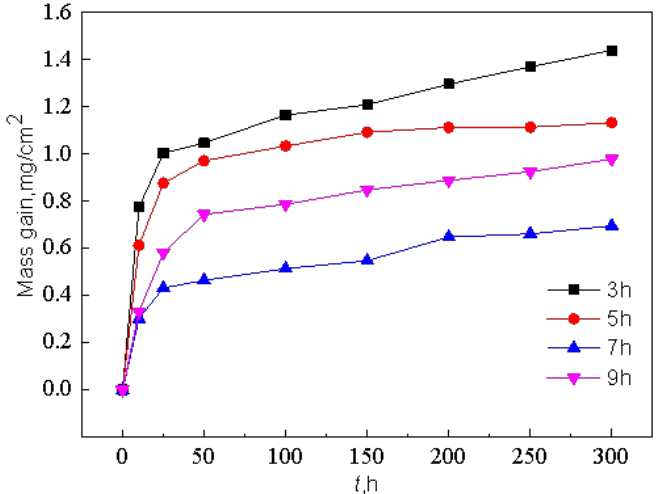
Figure 23. Kinetic curves of constant temperature oxidation of Al-Si coating at 1000 °C under different pre-oxidation times.